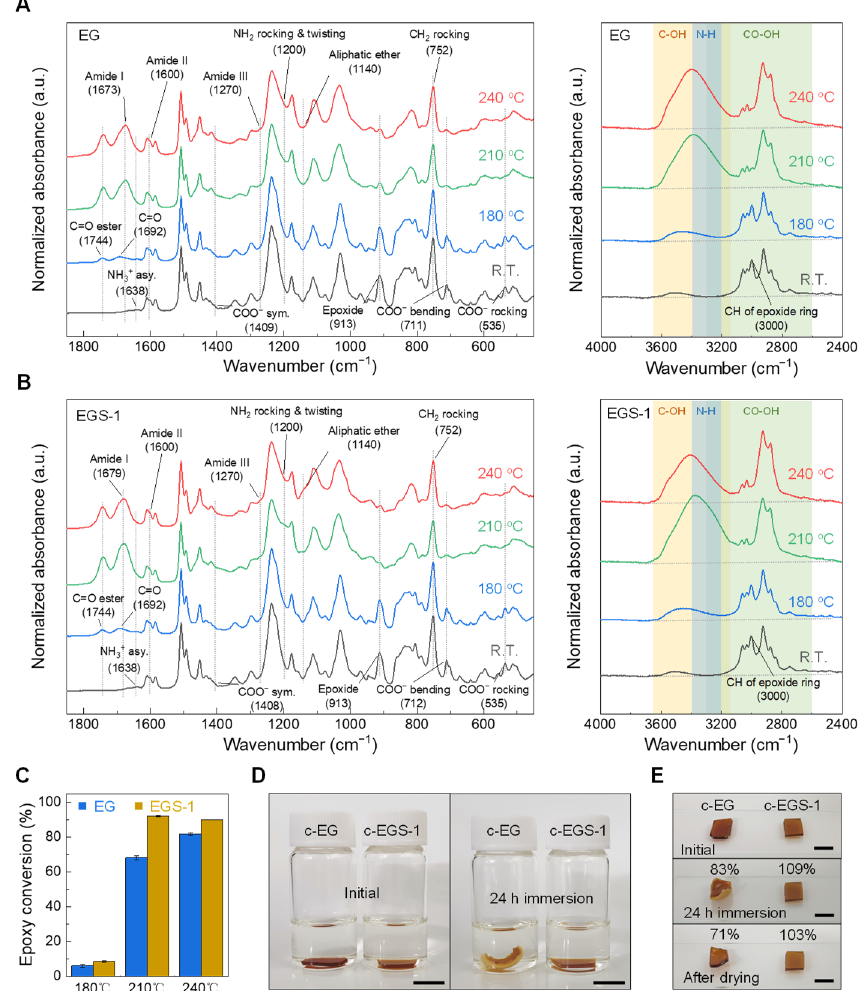
Figure 3. Crosslinking effect of SAC305 on the thermochemical reaction of DGEBF with Glu. ( A , B ) Representative low wavenumber (left) and high wavenumber (right) diamond ATR-FTIR spectra of EG ( A ) and EGS-1 ( B ) at room temperature, and after thermal reaction at 180/210/240 °C for 30 min, respectively. Owing to the broad absorption of diamond at ~2000 cm − 1 , data in the range of 1900 to 2400 cm − 1 were not considered. Gray dashed lines and shaded areas were used to indicate the changes in corresponding peaks. ( C ) Epoxy conversions of EG and EGS-1 after curing at 180/210/240 °C for 30 min, which were calculated from the corresponding FTIR spectra. Data are presented as mean ± SD, N = 5. The cured samples of EG and EGS-1 at 240 °C for 30 min are abbreviated as c-EG and c-EGS-1, respectively. ( D ) Photographs of c-EG and c-EGS-1 after immersion in 2-butanone for 0 h (left) and 24 h (right); scale bar, 0.5 cm. ( E ) Photographs of c-EG and c-EGS-1 before (top), immediately after the 24 h immersion test (middle), and after drying (bottom). Percentage values show the change in weight compared to the initial state; scale bar, 0.5 cm.